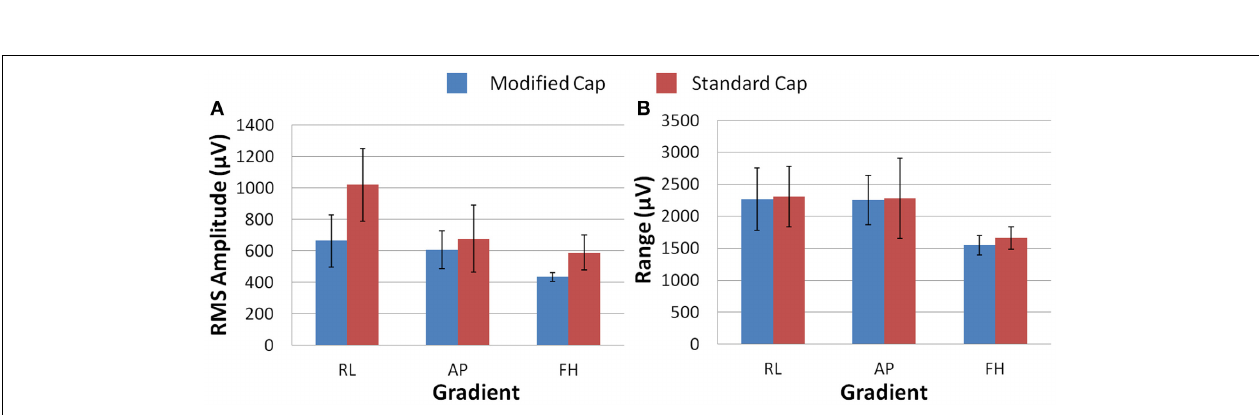
FIGURE 6 | The average RMS (A) and range (B) of the induced GA over recording repeats for each orthogonal gradient (RL, AP, and FH) on the phantom; for the modified (blue) and standard (red) lead paths. Error bars show the standard deviation of the measures over